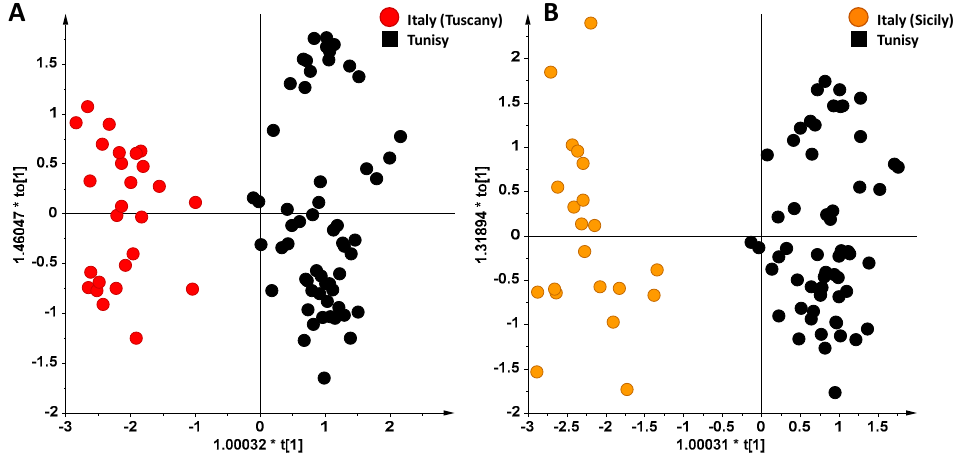
Figure 4. Orthogonal Partial Least Squares Discriminant Analysis, (OPLS-DA) scoreplots for EVOOs from Tuscan ( A ) and Sicilian ( B ) Italian regions vs. Tunisian oils.